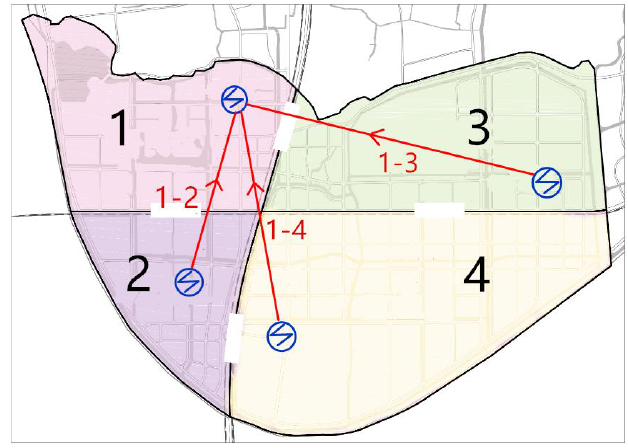
Figure 7. Geographical distribution of functional areas in Jianshan District.